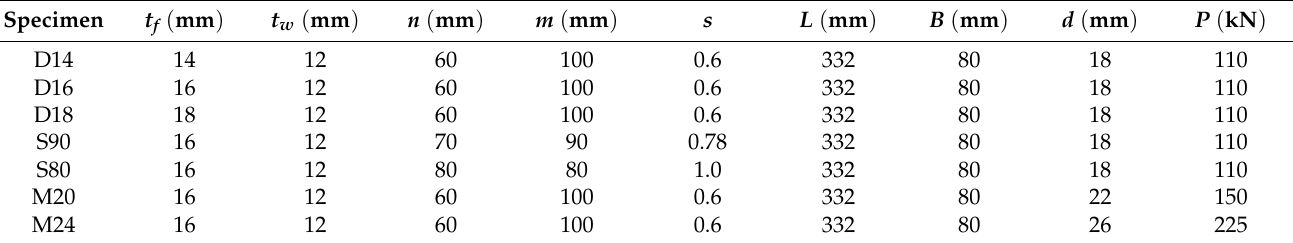
Figure 4. Schematic diagram of the T-stub. Figure 3. Tension test specimen.